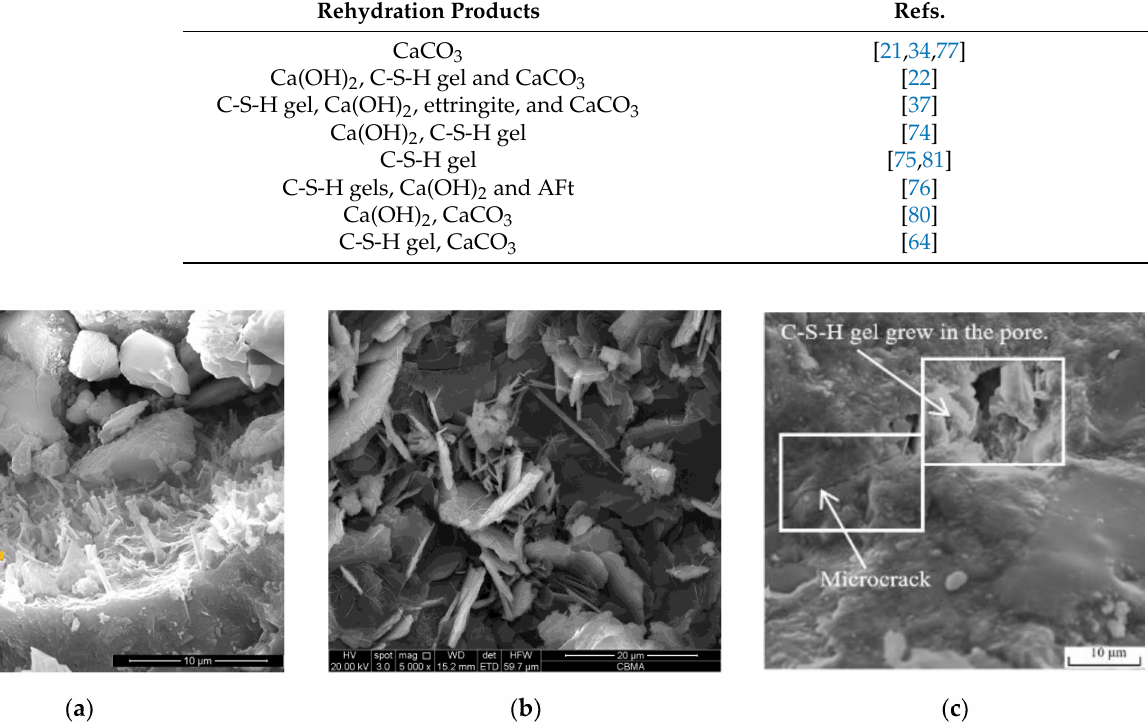
Figure 6. SEM images of the rehydration product morphology. ( a ) Ettringite. ( b ) Mixture of Ca(OH) 2 and CaCO 3; ( c ) C-S-H